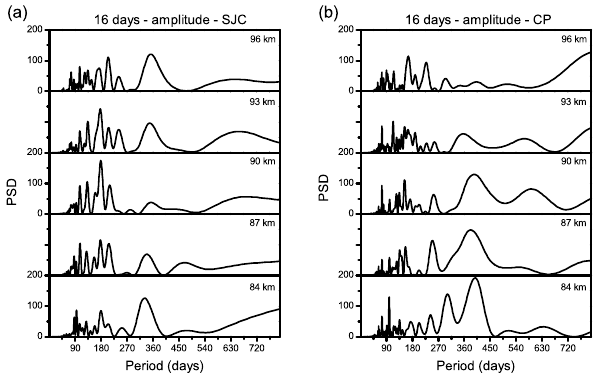
Figure 11. Lomb–Scargle periodograms obtained from amplitudes Fig. 11. Lomb-Scargle periodograms obtained from amplitudes of the 16-day oscillations for the zonal winds obtained on (a) Cariri and (a) of the 16-day oscillations for the zonal winds obtained over (a) C. Paulista for altitudes between 84 km and 96 km. Cariri and (b) C. Paulista, for altitudes between 84km and